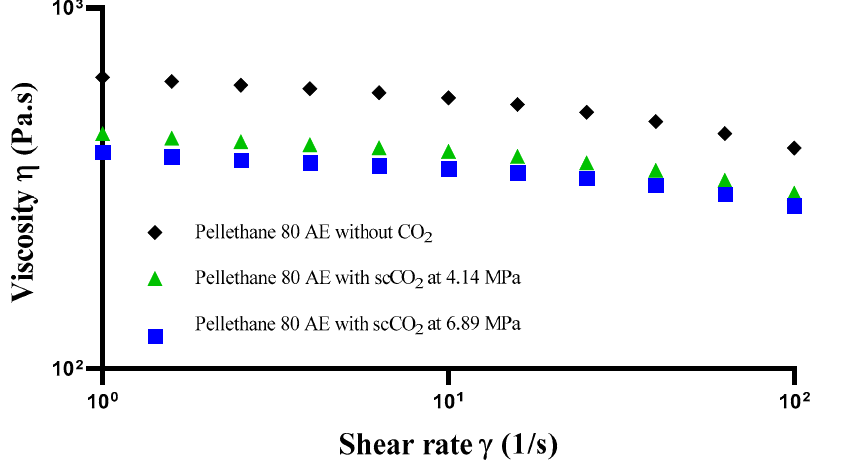
Figure 4. Viscosity dependence on shear rates for three different scenarios. Table 4. Zero-shear viscosity of Pellethane at three different